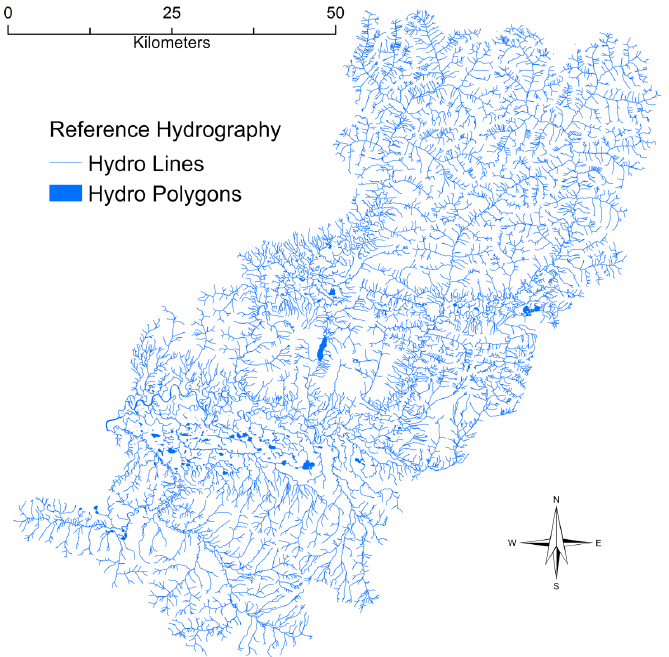
Figure 3. Reference 1:24,000-scale hydrographic features derived from 2012–2013 IfSAR data through a contract to the U.S. Geological Survey in September 2019. The hydrography derivation used a combination of routines based on flow direction, flow accumulation, geomorphons, and topographic openness, along with proprietary processing methods.